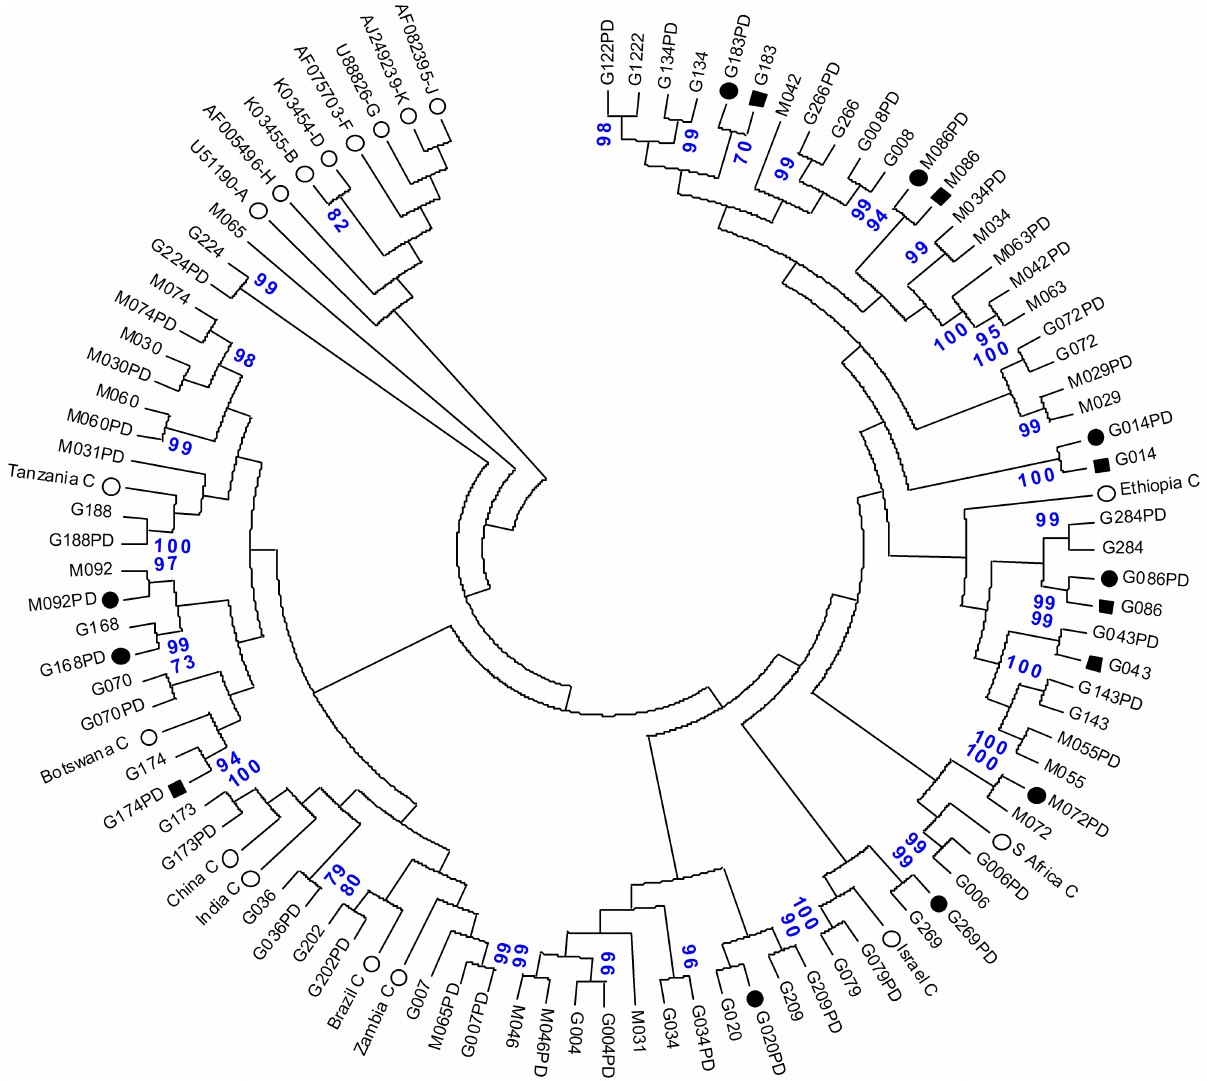
Fig 1. The neighbour-joining phylogenetic tree depicting the relationship between viral RNA (indicated with letter and number) and proviral DNA (indicated with letter, number and PD) from 41 treatment na ï ve patients in Northwest Ethiopia. Patients who developed HIV-1 drug resistance (black circles for HIV-1 proviral DNA and black rectangles for HIV-1 RNA) also indicated. For comparison, 17 reference strains (empty circles) from the Los Alamos HIV-1 database representing subtype C with GenBank accession numbers U46016 (Ethiopia C), AF067155 (India C), AF110980 (Botswana C), AF361874 (Tanzania C), AY772699 (S Africa C), U52953 (Brazil C), AF286233 (Israel C), AF286230 (China C), AF286225 (Zambia C), and A,B,D,F,G,H,J,K subtypes are included. The nucleotide sequences were submitted to GenBank (accession number: KJ807732— KJ807772 and KJ807649—KJ807689 for proviral DNA and viral RNA,